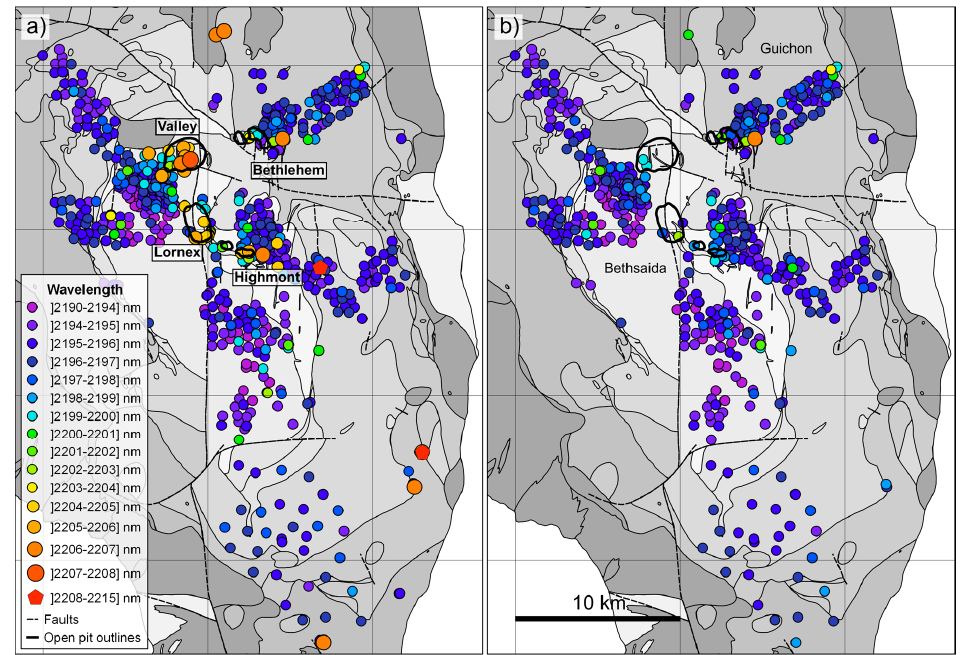
Figure 12 Figure 12. Regional map of the Guichon Creek batholith presenting the average 2200 nm absorption position for each of 755 slab samples with ( a ) no filtering by mineralogy and ( b ) only showing samples with no detected kaolinite or